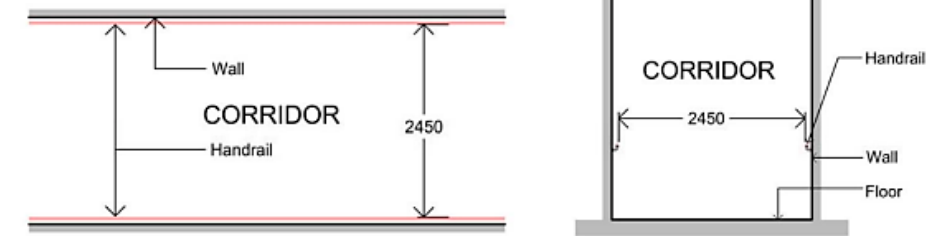
Figure 8. Minimum recommended clearance of patient corridor design (Adapted from [73]).